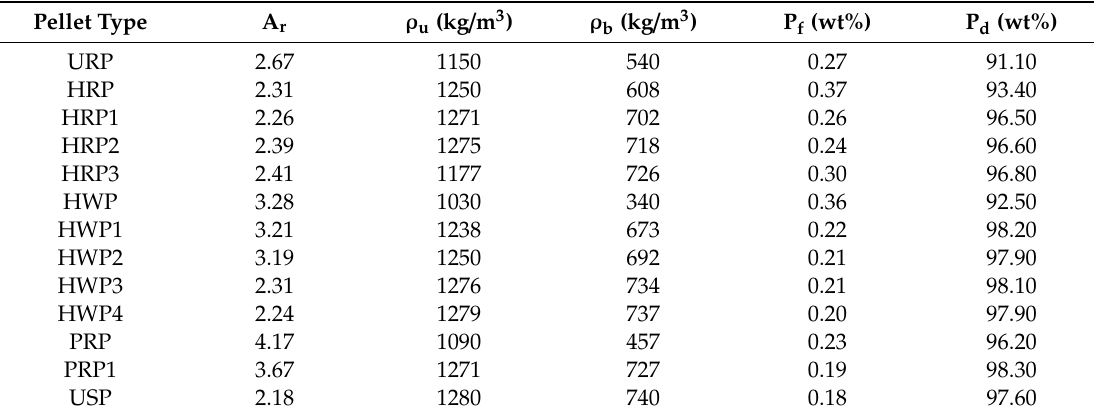
Table 4. Properties of di ff erent fuel